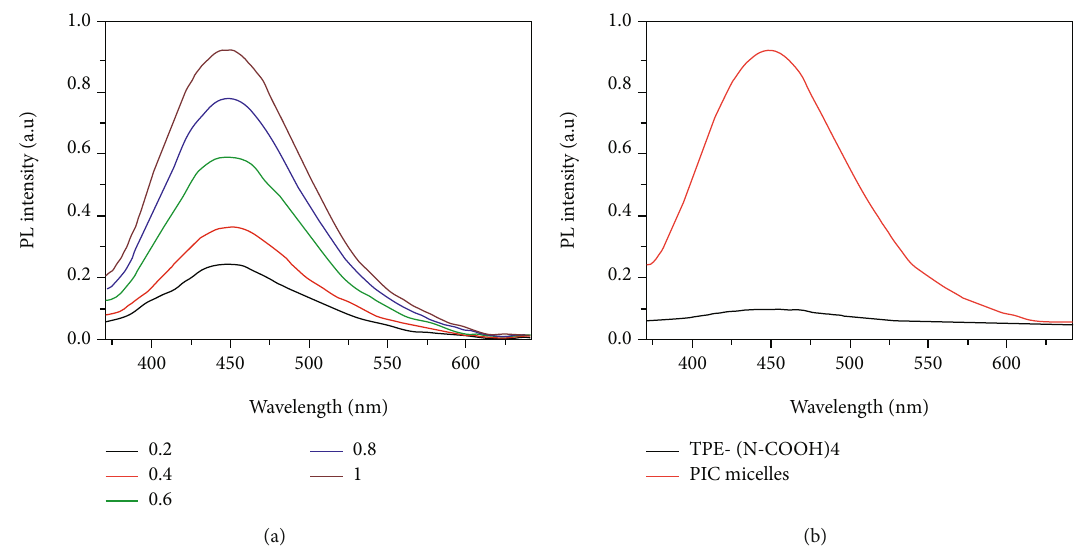
Figure 3: (a) Fluorescence spectra of PIC micelles formed from WCS and TPE-(N-COOH) [NH 3+ ]/[COO - ]. (b) Fluorescence spectra obtained for TPE-(N-COOH) TPE-(N-COOH) at the [NH 3+ ]/[COO - ] molar ratio of 1.0. pH = 8 , λ ex = 345 nm. The TPE-(N-COOH) 4 1.0g/L in all case. The emission intensities measured at various ratios were normalized to the initial